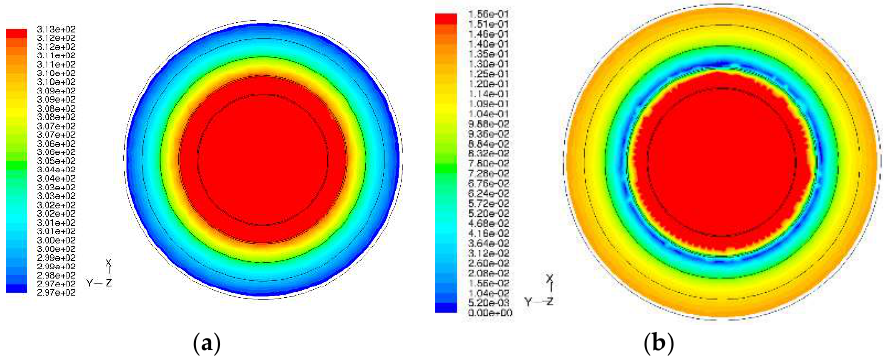
Figure 8. The cross-section representations for the first simulation version (v = 2 m/s; T = 313 K = 40 °C). ( a ) Temperature field (K); ( b ) absolute humidity field (kg water vapors/kg dry product) [20].